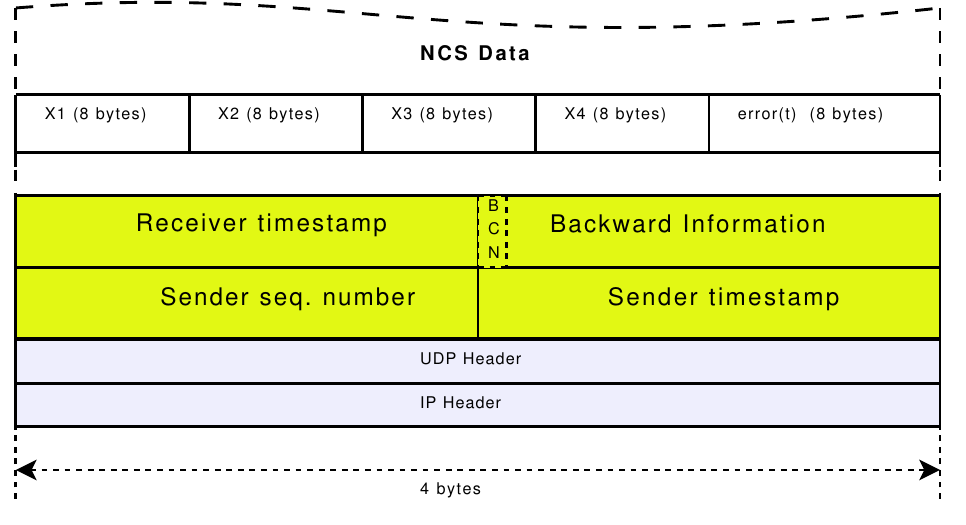
Bidirectional transport header for trinomial algorithm and data structure for tele-operated gantry